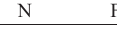
Table 1. The chemical composition of AISI 316L. Element wt%